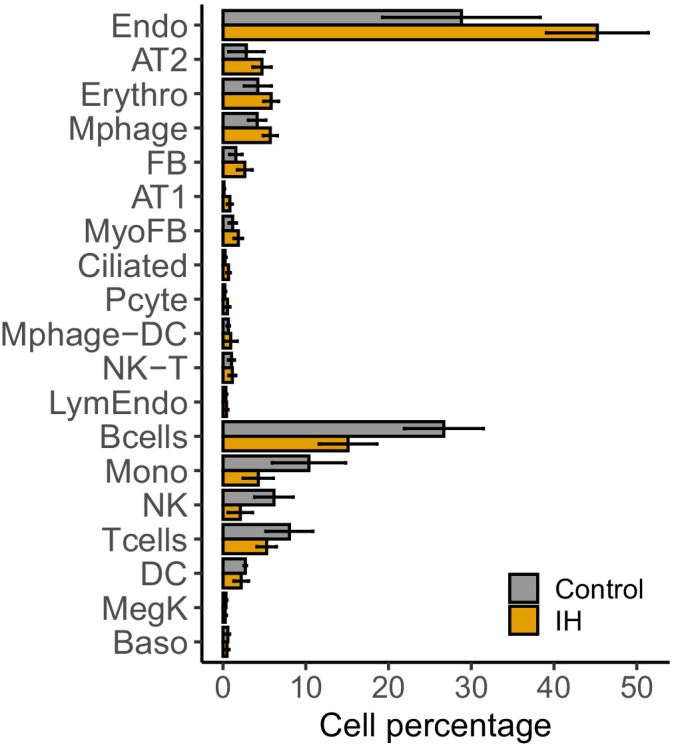
Percentage of detected lung cell types from mice exposed to IH vs controls.(A) Percentage of each cell type from experimental and control mice. Error bars indicate standard deviation of cell proportion from the three biological replicates. The list of cell types include: endothelial cells (Endo), B cells (Bcells), natural killer cells (NK), T cells (Tcells), natural killer T cells (NK-T), macrophages (Mphage), basophils (Baso), monocytes (Mono), macrophages-dendritic CD163+ cells (Mphage-DC), dendritic cells (DC), megakaryocytes (MegK), fibroblasts (FB), myofibroblasts (MyoFB), pericytes (Pcyte), alveolar epithelial type I cells (AT1), lymphatic endothelial cells (LymEndo), erythroblasts (Erythro), alveolar epithelial type II cells (AT2), and ciliated cells (Ciliated).